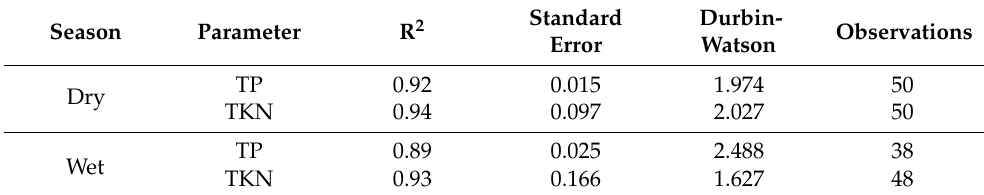
Table 6. Regression analyses for TP and